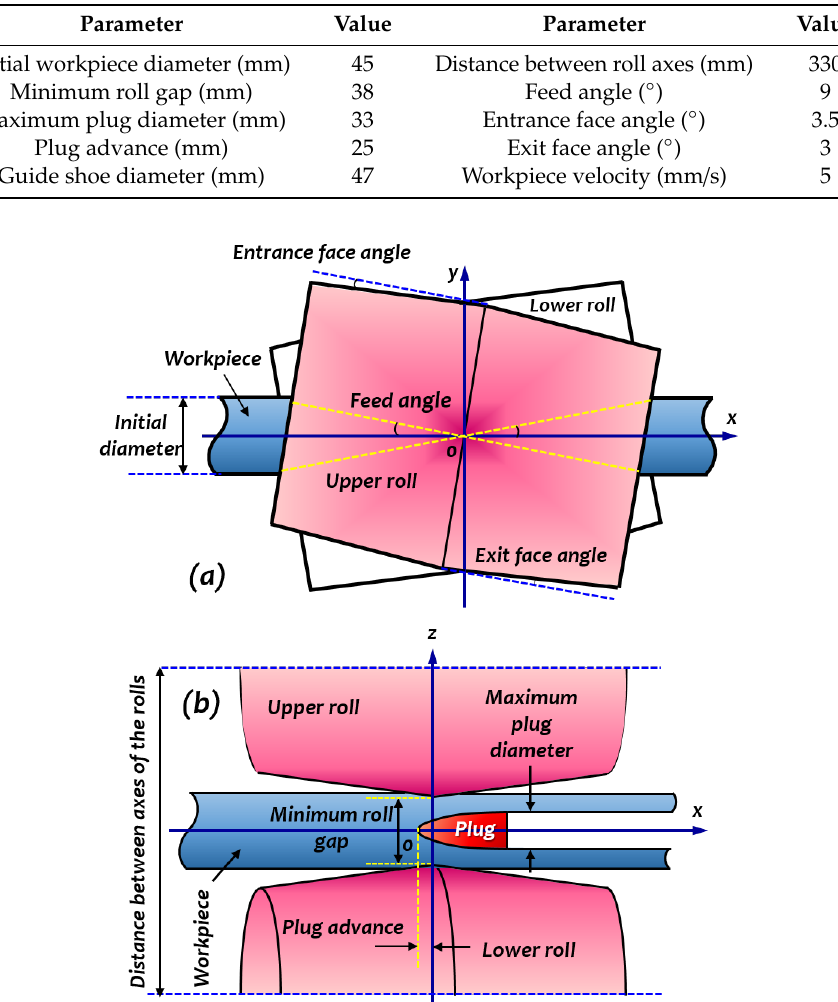
Figure 4. Schematic diagram of the piercing process ( a ) Top view and, ( b ) Side view.